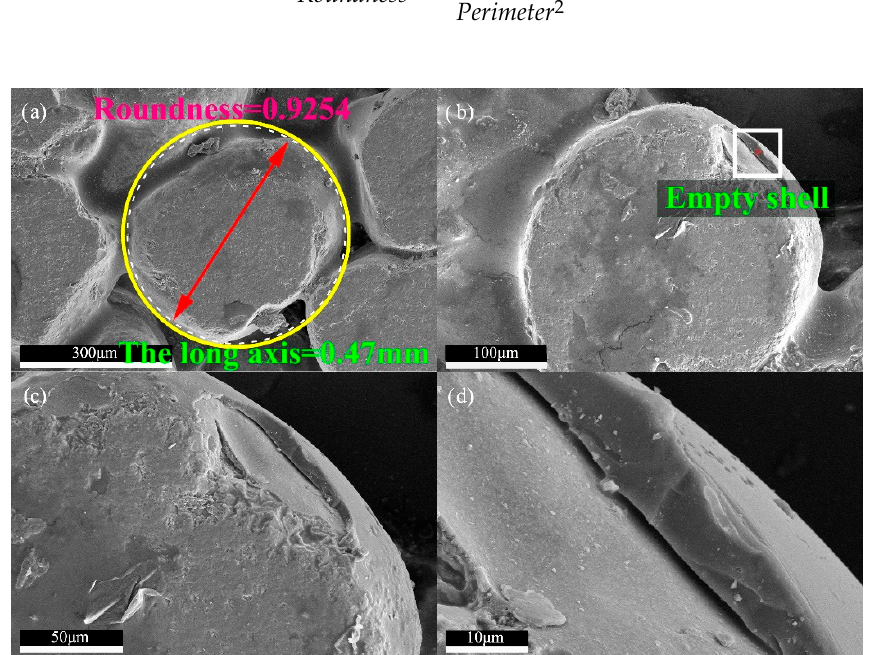
Figure 18. Apparent characteristics of RBPB’s aggregate and peelable surface defects. ( a ) Roundness and the length of the long axis of a particle. ( b ) Surface defect. ( c ) Empty shell. ( d ) Detail of the empty shell.